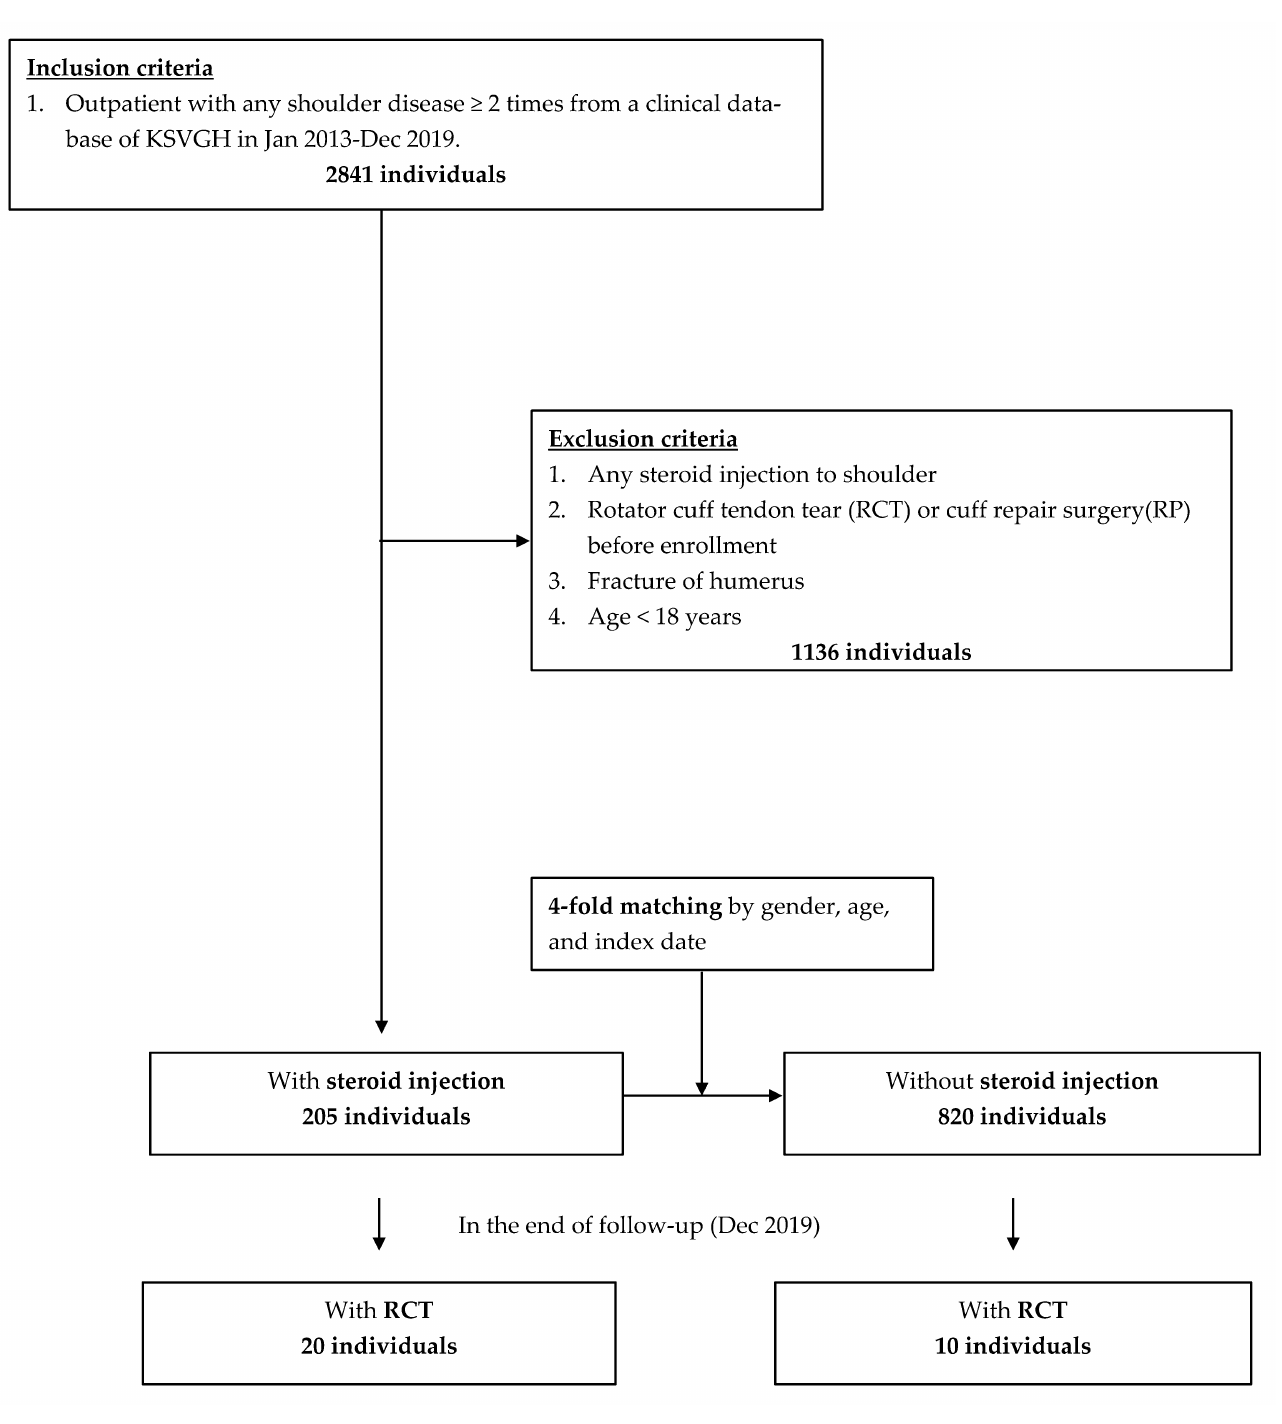
Figure 1. Flowchart. Figure 1.